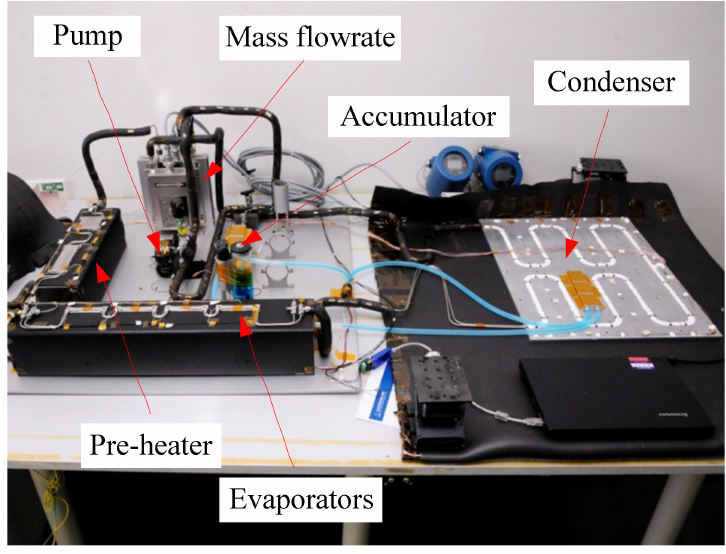
Figure 3. Experimental setup of MPTL